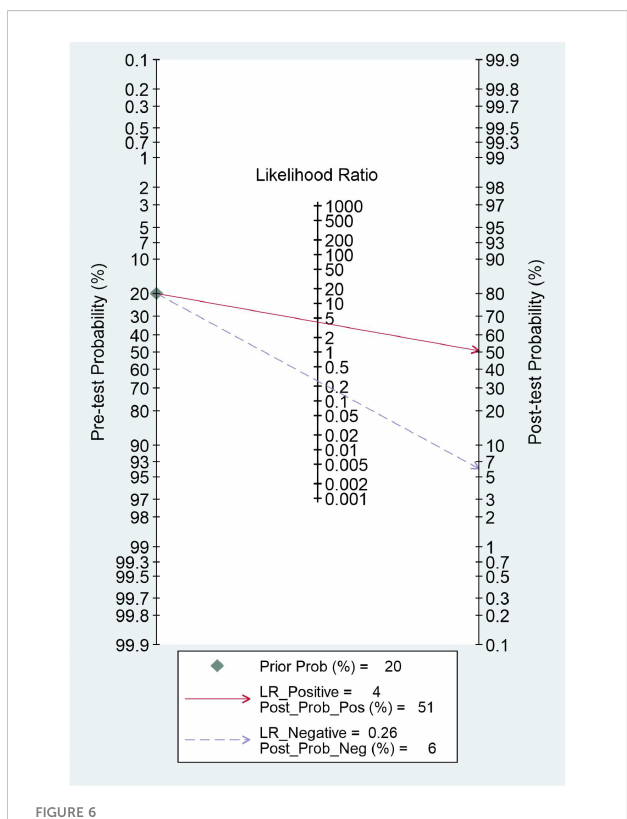
FIGURE 6 Fagan nomogram for the elucidation of post-test probabilities with a pre-test